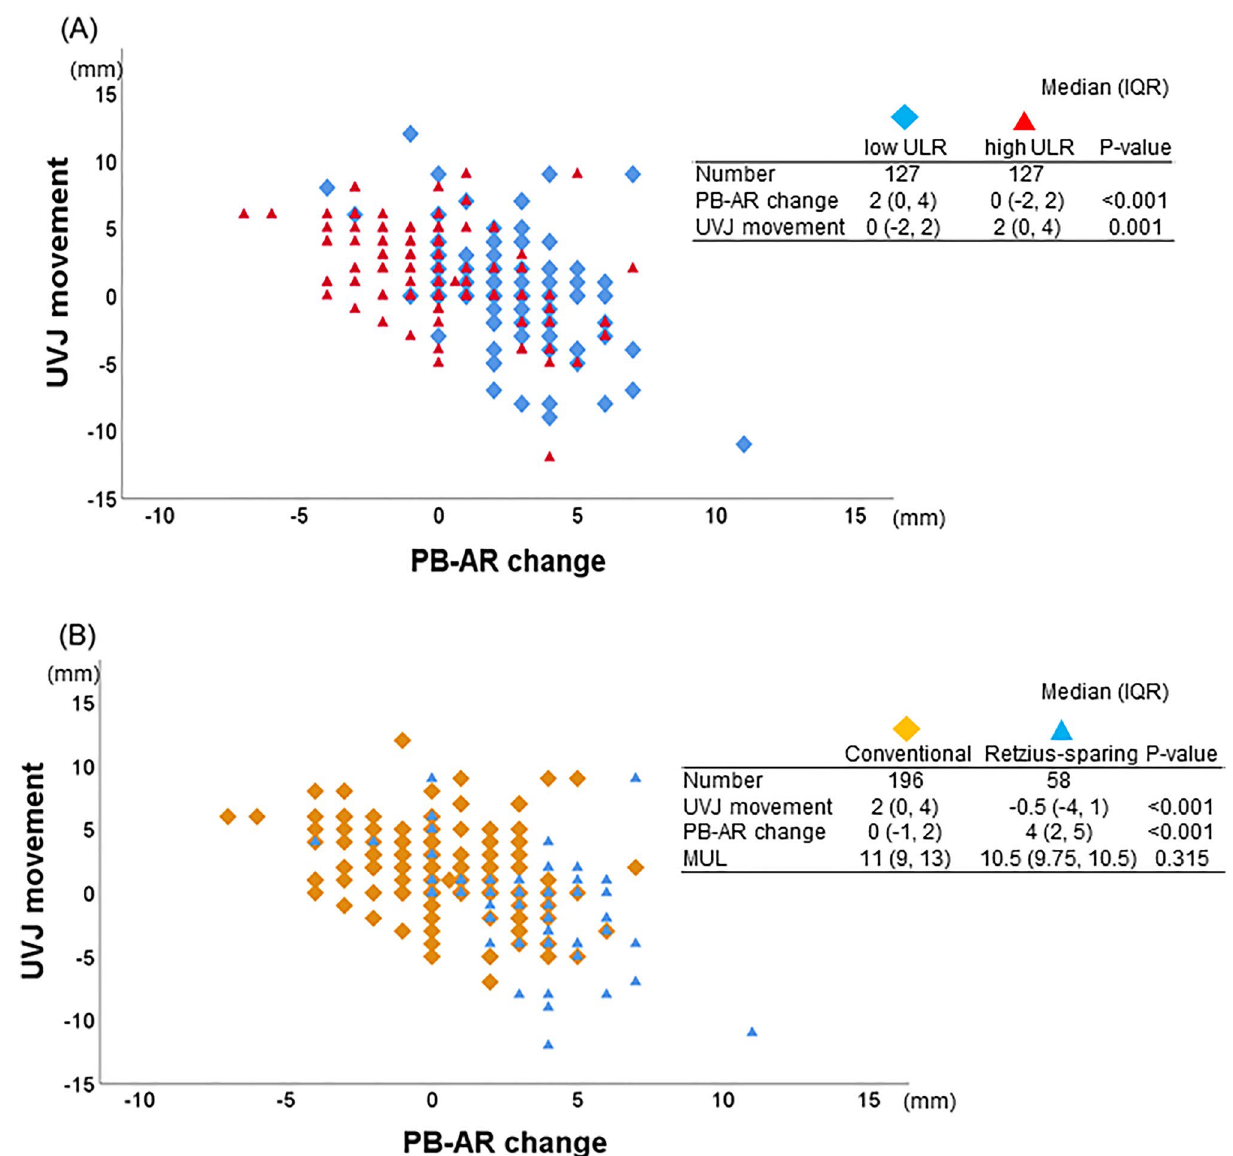
Figure 2. ( A ) Distribution of pubic bone to anterior rectum (PB-AR) change and urethrovesical junction (UVJ) movement for each case by the urine loss ratio (ULR). ( B ) Distribution of PB-AR change and UVJ movement for each case by conventional and Retzius-sparing robot-assisted radical